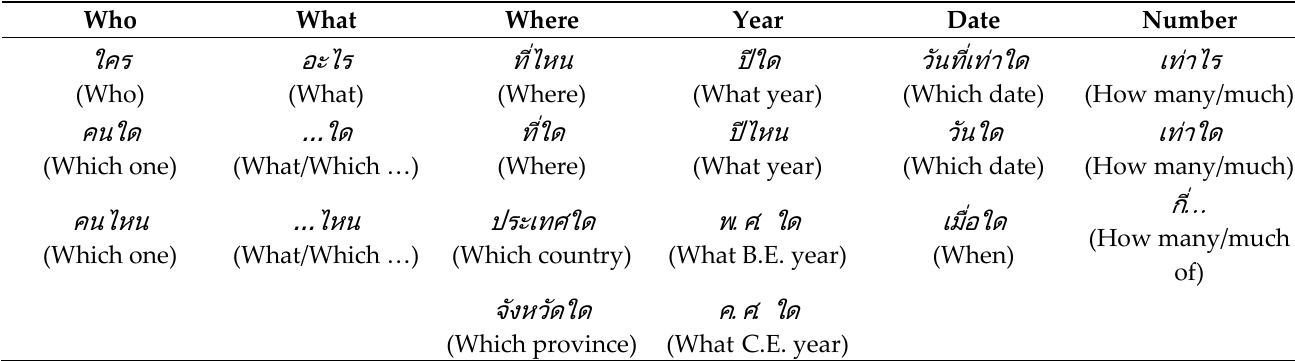
Table 8. Example of question word categories in Thai.